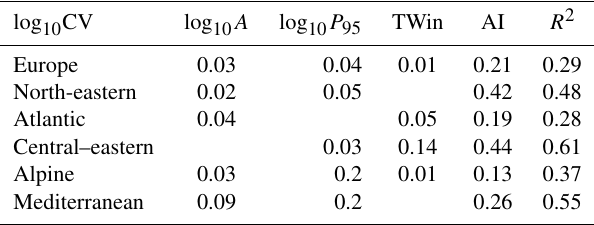
Table A4. Measure of general dominance (additional contributions) for CV – indicating general dominance. For each row: the highest value indicates the most important variable in terms of improvement of the model fit for the given regression, the second highest indicates the second most important, and the lowest indicates the least important. Summing over measures gives R 2 of regression.